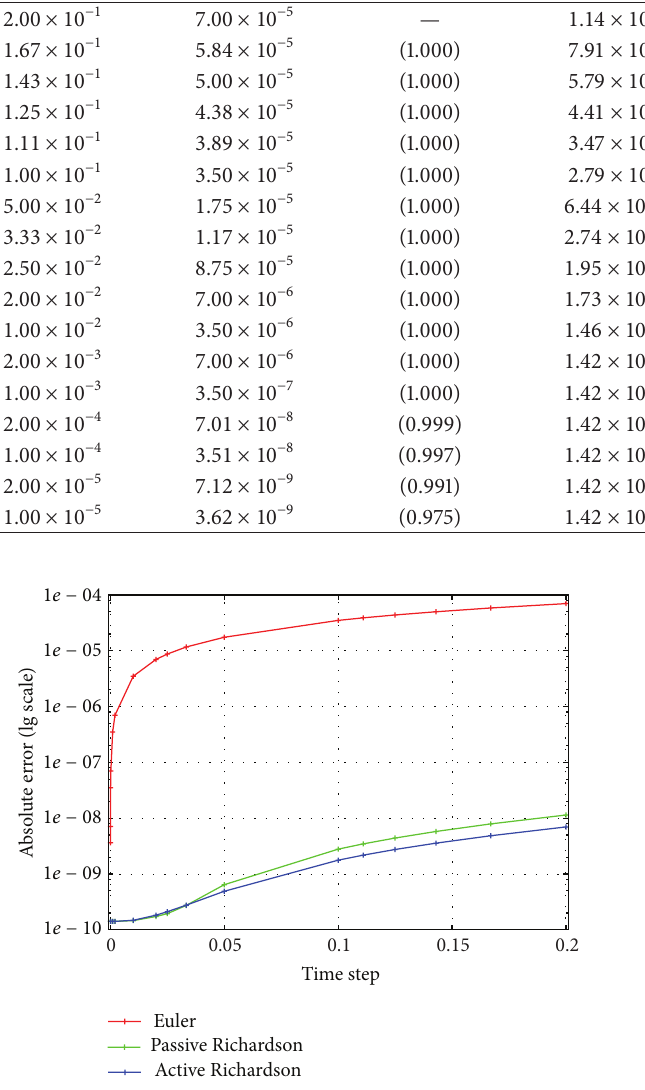
Figure 3: Relative error as a function of time step for the Euler method without and with passive and active Richardson extrapo- lation, by grid step Δ𝑥 = 1 and coefficient 𝐷 = 1.0 . The reference solution was calculated using Δ𝑡 = 10 −7